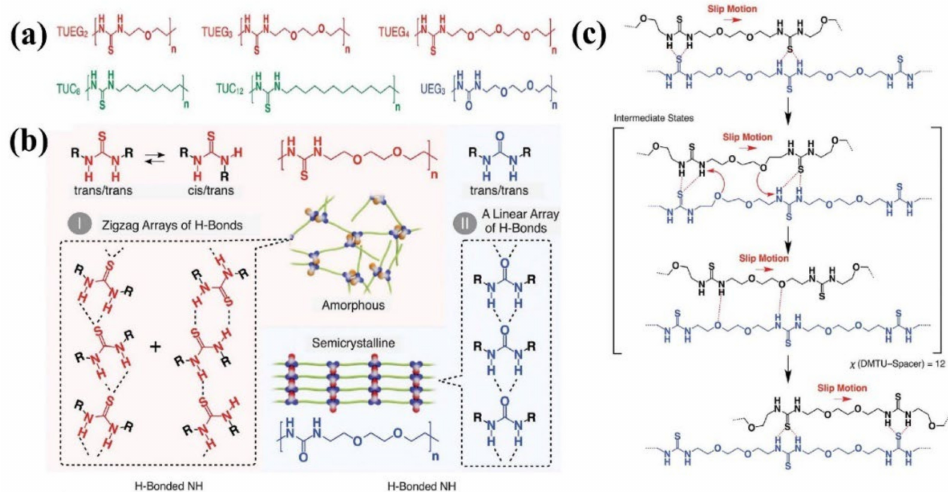
Figure 5. ( a ) Schematic structures of poly(ether-thioureas) with diethylene glycol (TUEG2), tri- ethylene glycol (TUEG3), and tetraethylene glycol (TUEG4) as spacers; schematic structures of poly(alkylene-thioureas) with octamethylene (TUC8) and dodecamethylene (TUC12) chains as spacers; and schematic structure of a poly(ether-urea) with triethylene glycol (UEG3) as a spacer. ( b ) Schematic representations of the H-bonding modes of thiourea and urea. ( c ) Proposed mechanism of how the exchange of H-bonded thiourea pairs in TUEG3 is enhanced. Reproduced with permission from [97]. Copyright (2018) American Association for the Advancement of